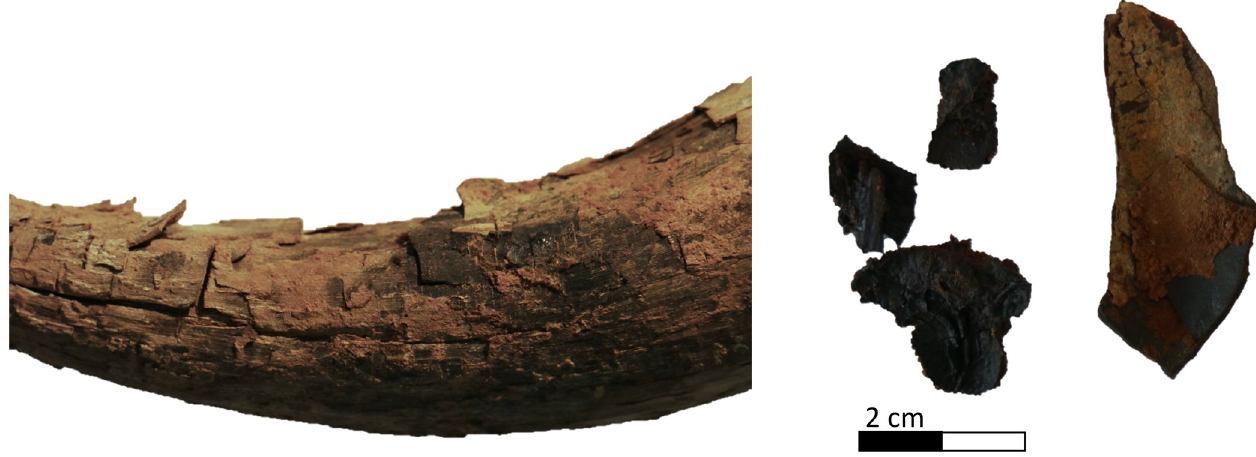
Fig 18. Sheath #0034 with a burnt area and burnt flakes from the inner layers.